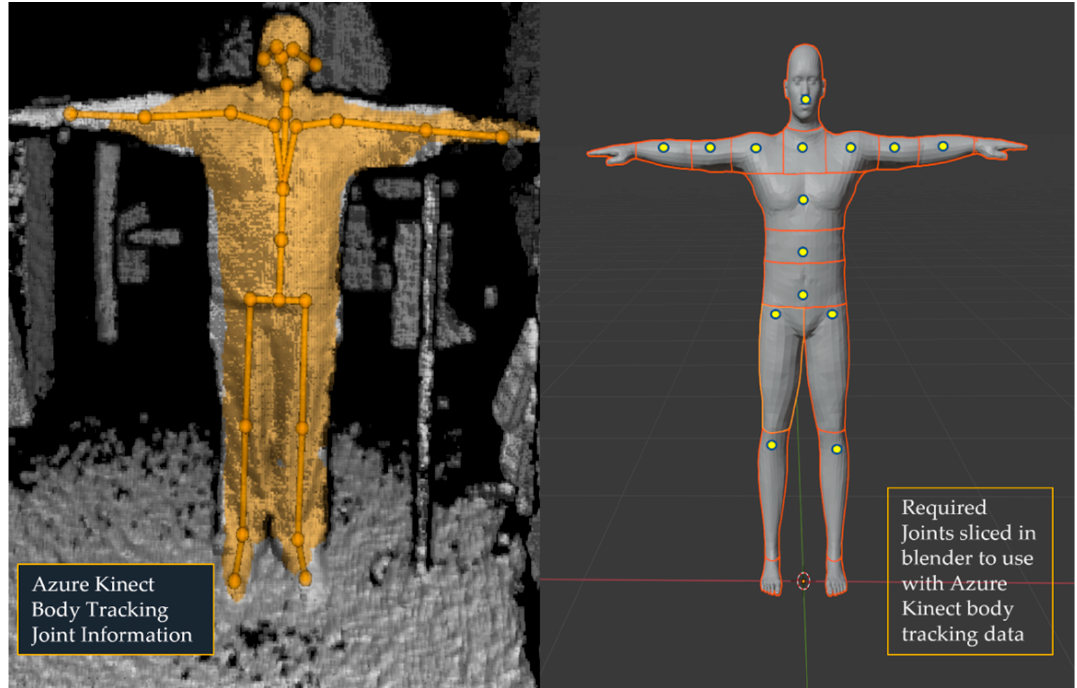
Figure 9. Overview of the model used in RViz for visualisation. ( Left ) shows the skeleton and joint information obtained from the Azure Kinect Camera. ( Right ) A human model developed using MakeHuman and sliced into various parts using Blender. The pictures show the sliced region of the human model used for visualization in RViz.